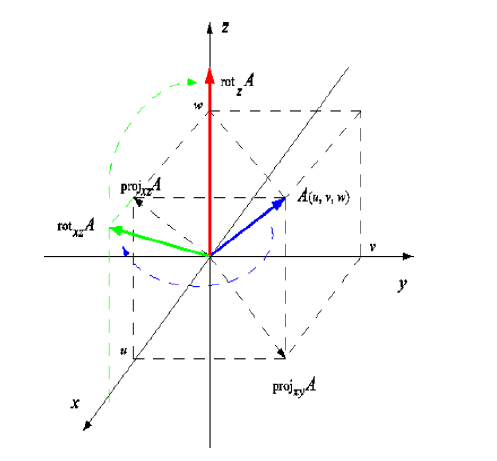
Figure 4. Rotation of undefined pole in 3 D